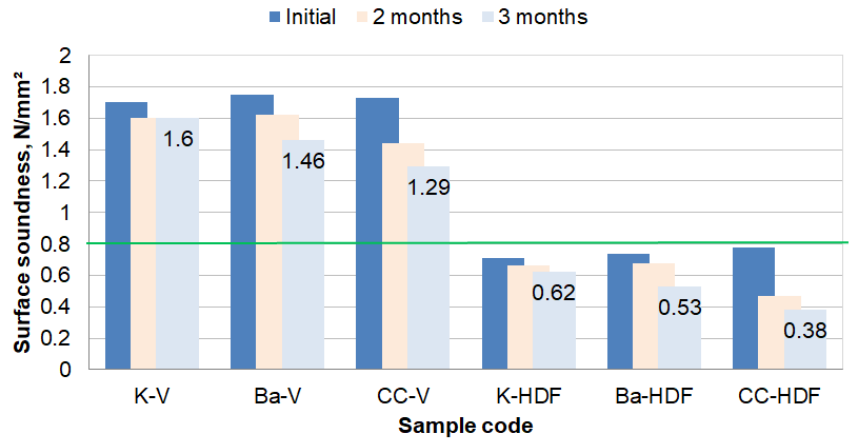
Figure 11. Surface soundness results